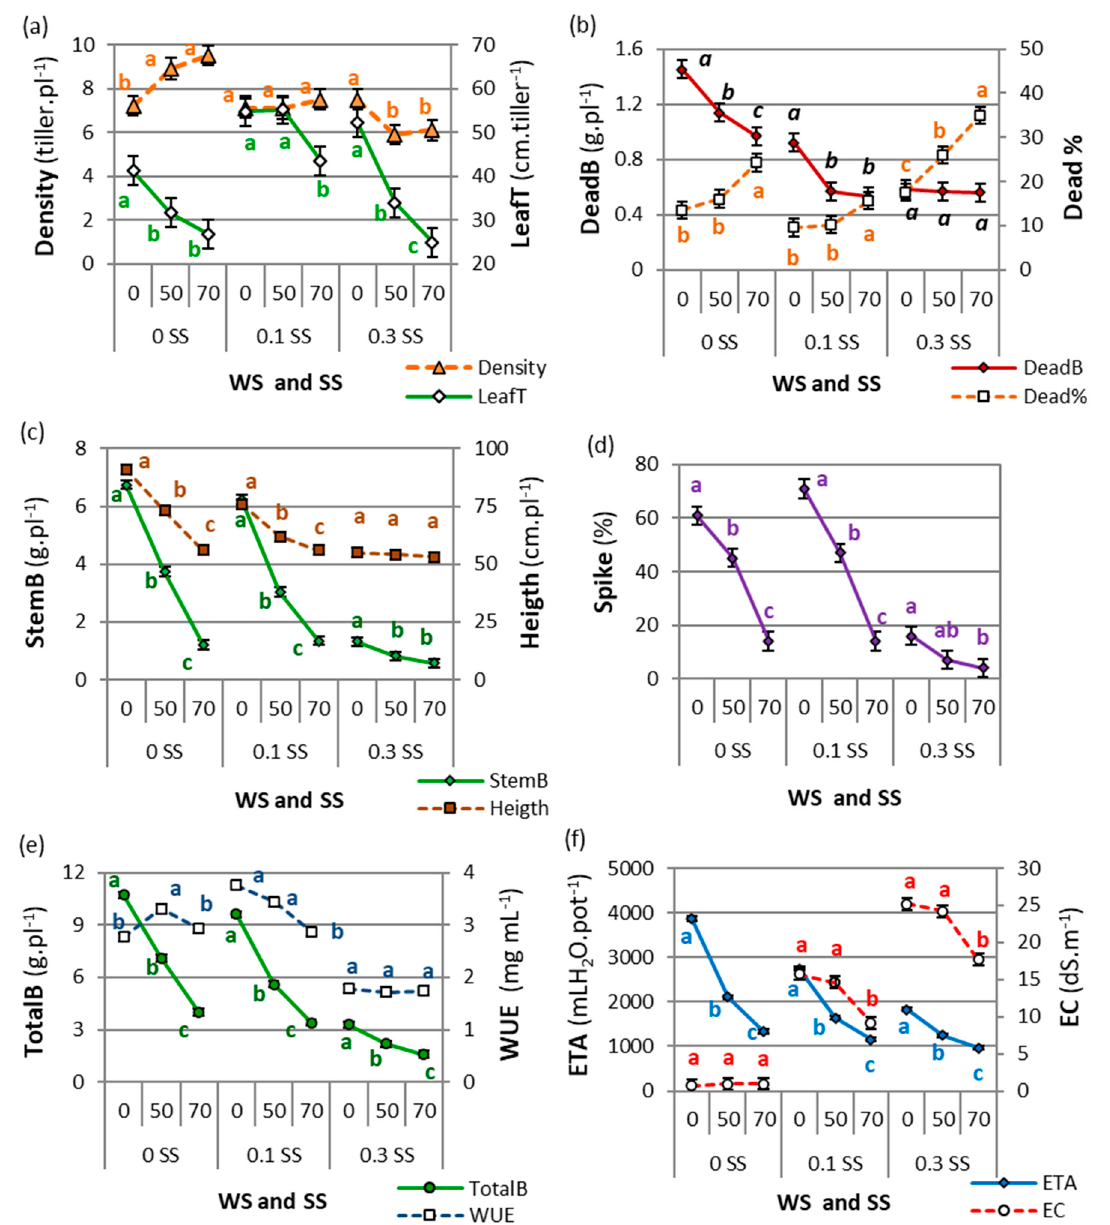
Figure 1. Drought and salinity interactions (WS and SS) for: tiller density and leaf length per tiller (LeafT) ( a ), dead biomass (DeadB) and percentage of dead biomass (Dead%) ( b ), stem biomass (StemB) and plant height (Height) ( c ), proportion of spiked tillers (Spike%) ( d ), total biomass (TotalB) and water-use efficiency (WUE) ( e ), and accumulated evapotranspiration (ETA) and electrical conductivity (EC) ( f ). For each variable, different letters indicate significant differences (LSD, p < 0.05) between drought levels (WS: 0, 50, or 70, corresponding to 100%, 50%, or 30% water capacity, respectively) for each level of salinity (SS: 0, 0.1, or 0.3, corresponding to 0.0, 0.1, or 0.3 M NaCl, respectively). Points are means of 4 tall wheatgrass accessions and 5 blocks ( n = 20). Bars indicate the means standard error.